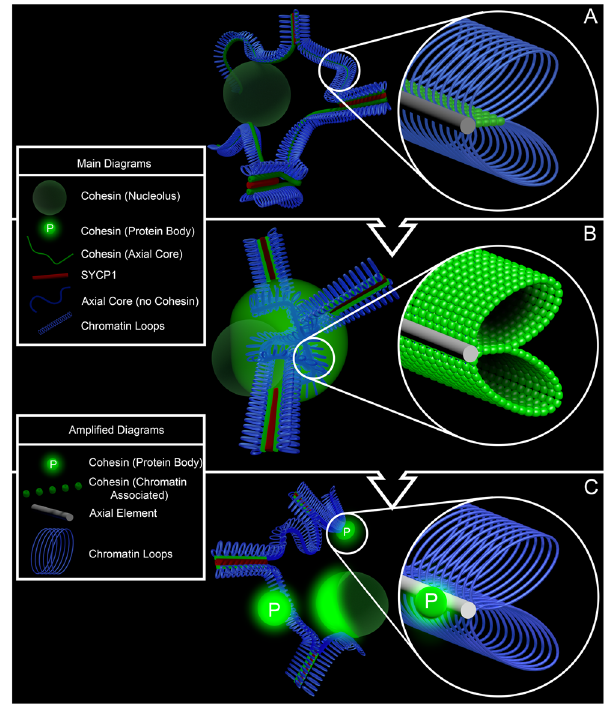
Figure 9. Schematic of platypus sex chromosome and cohesin dynamics during pachytene. In early pachytene ( A ), the sex chromosome chain is attached at one end to the large nucleolus and is spread throughout the nucleus. At this stage greater cohesin loading is observed on the chromosomal axes of the asynaptic regions of the chain. At mid-pachytene, the asynaptic regions of the sex chromosomes are located at a paranucleolar region and at this stage it appears that the SMC3 is recruited to the chromatin loops of the unpaired regions of the chain. By late pachytene, the sex chromosomes begin to spread back out into the nucleus and SMC3 is removed not only from the chromatin loops, but also the axial cores and relocates into protein bodies. The protein bodies spread out in the same direction as the sex chromosomes indicating the protein bodies are physically connected to the sex chromosomes, thus we have depicted an attachment with the chromosomes axial core. Note that in all stages, the sex chromosome chain is attached to the nucleolus which maintains a relatively central location in the nucleus. Also, at all times the PARs form a normal synaptonemal complex and do not accumulate SMC3 onto their chromatin loops at any